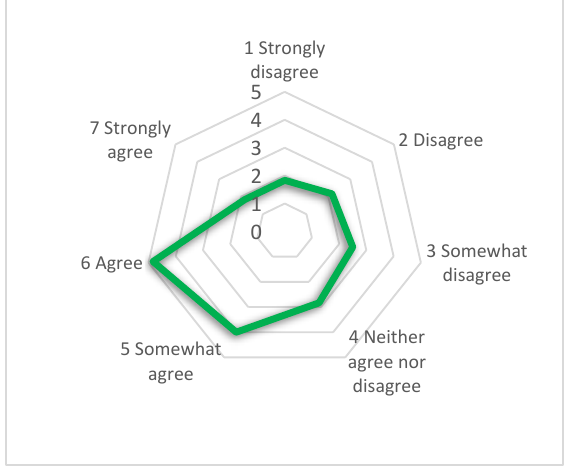
Figure 19. Enjoyment assessment.